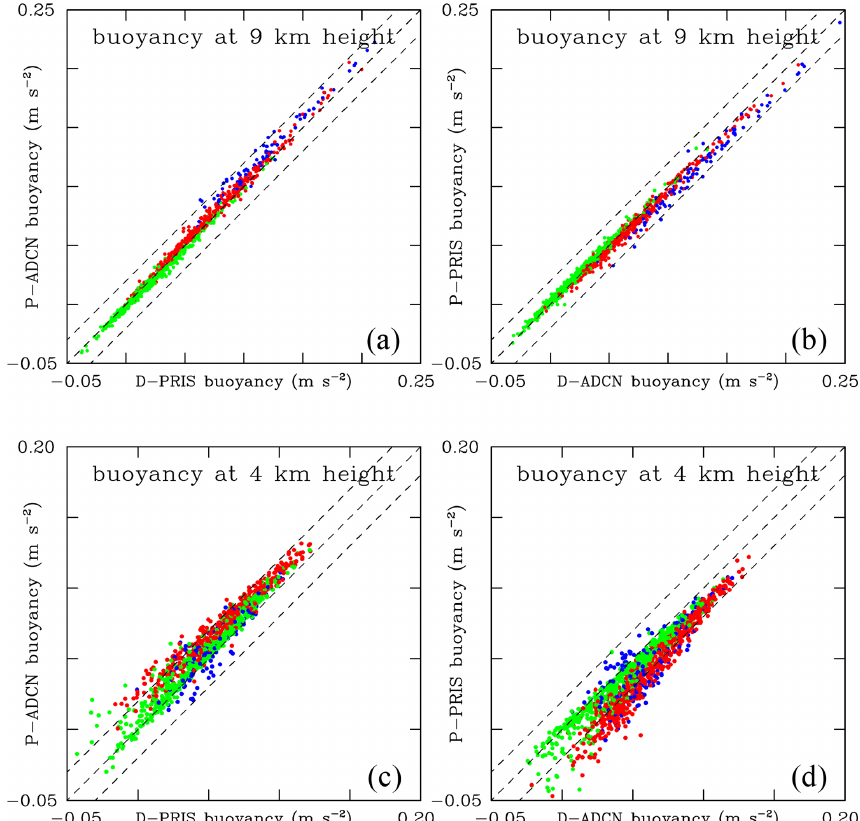
Figure 12. Driver versus piggybacker buoyancy at (a, b) 9km and (c, d) 4km height and hours 6 and 7 for all members of PRIS and ADCN ensembles. Driver buoyancy is shown on the horizontal axes (D-PRIS in a and c and D-ADCN in b and d ). Piggybacker buoyancy is on the vertical axes. Symbol colors represent vertical velocity at the location from which driver and piggybacker buoyancies are taken. At 4km, green, red, and blue represent updrafts between 1 and 5, 5 to 10, and above 10ms − 1 , respectively, with only 2% of all points shown for green, 10% for red, and all for blue. At 9km, green, red, and blue colors represent updrafts between 1 and 10, 10 to 20, and above 20ms − 1 , with 4% of all points shown for green, 20% for red, and all for blue. Middle dashed lines show equal buoyancies, and the lines above and below show buoyancies offset by 0.02ms − 2 . Only points with vertical velocity larger than 1ms − 1 and total condensate mixing ratio larger than 1gkg − 1 are included in the plot.